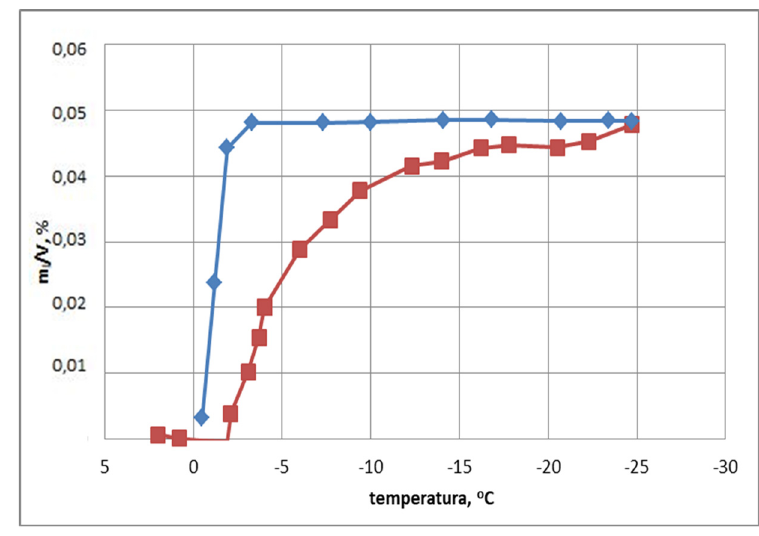
Figure 6. Full hysteresis of m L /V p in sample B1.